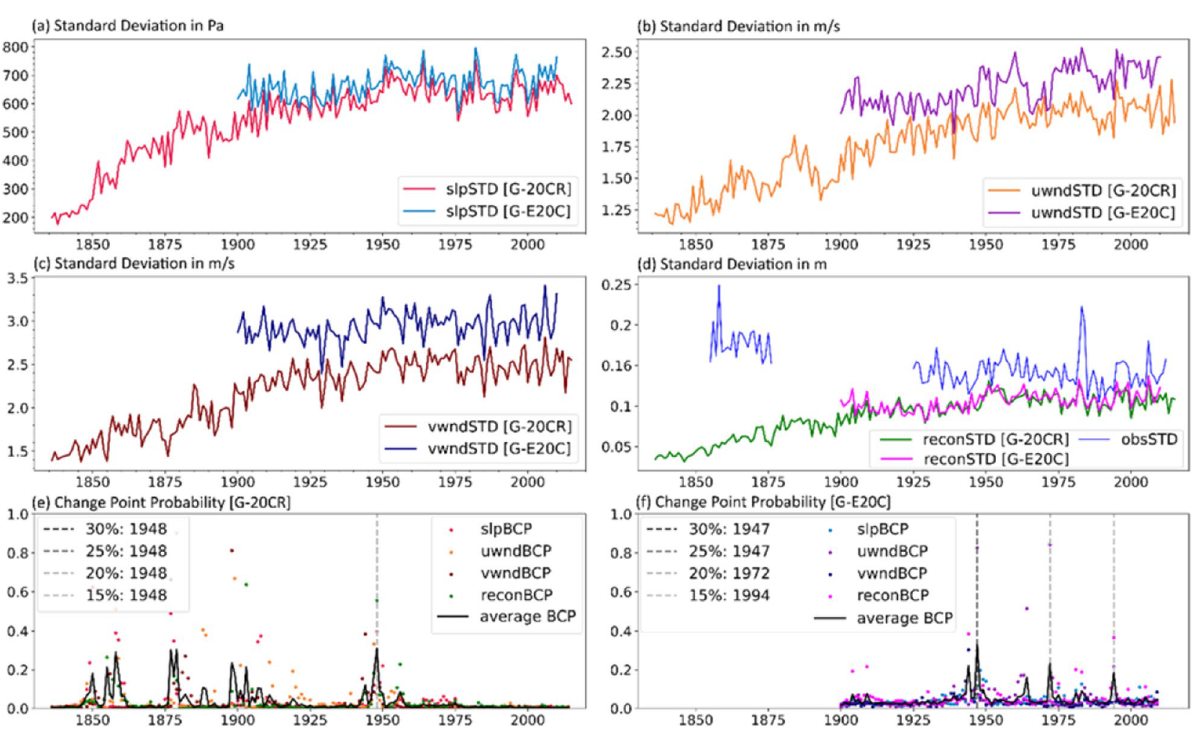
Figure 2. Results of change point analysis for G-20CR and G-E20C for the Astoria tide gauge. Annual variability (expressed as standard deviation) time series are shown for ( a ) sea-level pressure (slpSTD), ( b ) zonal wind speed (uwndSTD), ( c ) meridional wind speed (vwndSTD), and ( d ) reconstructed surge (reconSTD). ( e , f ) Bayesian change point probability (BCP) for the surge reconstruction and predictors (colored dots) and the average of them (black solid line) for G-20CR ( e ) and G-E20C ( f ); vertical dashed gray lines indicate the most recent change point year for a given cutoff probability for the average (US) (Fig. 2e,f), along with the annual variability of the three predictors used in Tadesse and Wahl 31 (Fig. 2a–c), as well as the annual variability in the surge reconstructions and the observed surge (Fig. 2d). The average of the four change point probabilities corresponding to the zonal wind speed, meridional wind speed, mean sea-level pressure, and reconstructed surge are computed and presented in Fig. 2e,f. The change point detection algorithm computes the probability of each year that it constitutes a change point in the time series (see “Methods” for